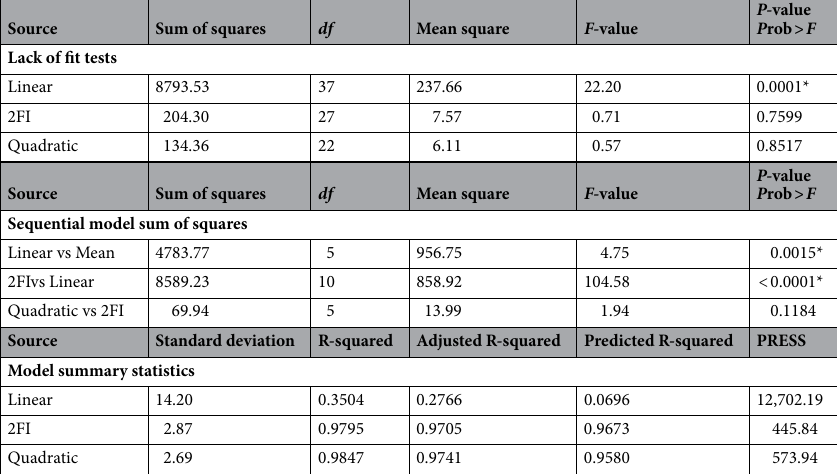
Table 4. Fit summary for simultaneous biosorption of Congo red by E. intestinalis achieved by the FCCCD. *Significant values, df , degree of freedom; PRESS, sum of squares of prediction error; two factors interaction,